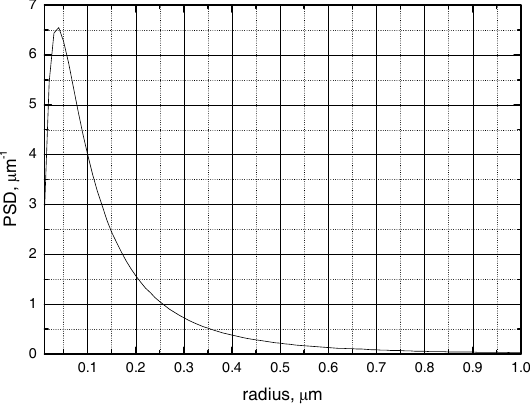
Fig. 2. Spectral normalized extinction coefficient κ(λ) = K ext (λ)/K ext (λ 0 ) , where λ 0 =